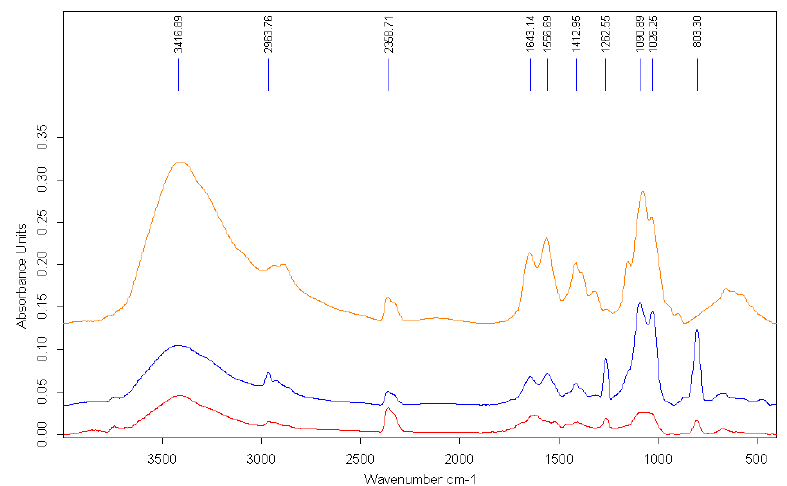
Figure 4. The FTIR spectra of AgNPs stabilized with chitosan solution (HMW) (yellow = pure chitosan; blue = AgNPs stabilized in 2% chitosan solution; red = AgNPs stabilized in 0.2% chitosan solution).